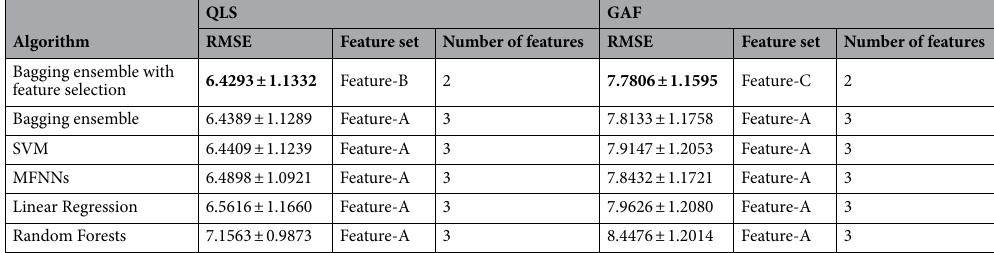
Table 1. The results of repeated tenfold cross-validation experiments for predicting the QLS and GAF functional outcome of schizophrenia with clinical symptom scales using machine learning predictors such as the bagging ensemble model with feature selection, the bagging ensemble model, MFNNs, SVM, linear regression, and random forests. The best QLS or GAF scores are given in bold. Feature-A: 3 features (related to 3 clinical symptom scales) including PANSS-Positive, SANS20, and HAMD17. Feature-B: 2 features (related to 2 clinical symptom scales) including SANS20 and HAMD17. Feature-C: 2 features (related to 2 clinical symptom scales) including PANSS-Positive, and SANS20. GAF = Global Assessment of Functioning; HAMD17: 17-item Hamilton Depression Rating Scale; MFNNs = Multilayer Feedforward Neural Networks; PANSS-Positive: the Positive and Negative Syndrome Scale-Positive subscale; QLS = Quality of Life Scale; RMSE: Root Mean Square Error; SANS20: 20-item Scale for the Assessment of Negative Symptoms; SVM = Support Vector Machine. Data are presented as mean ± standard